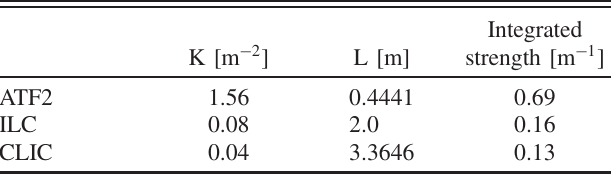
TABLE VII. Comparison between the integrated strength of the QF1FF magnet between ATF2, ILC, and